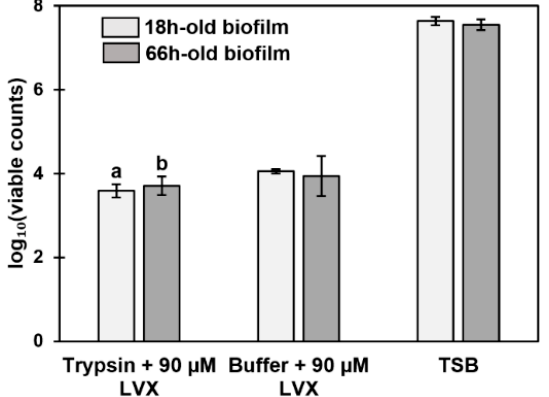
Figure 8. Viability of 18- and 66-h-old S. aureus ATCC 25923 biofilms treated with trypsin and 90 µM levofloxacin (LVX), triethylammonium bicarbonate buffer (TEAB) (trypsin buffer) and 90 µM levofloxacin or tryptic soy broth (TSB). The number of viable cells is expressed as log 10 values of CFU (mL · cm 2 ) − 1 . The statistical analysis was performed using unpaired t -tests with Welch’s correction. Highly significant change in viability ( p < 0.001) compared to (a) TSB at 18 h time point and (b) TSB at 66 h time point. Error bars denote the standard error of the mean (SEM) ( n =